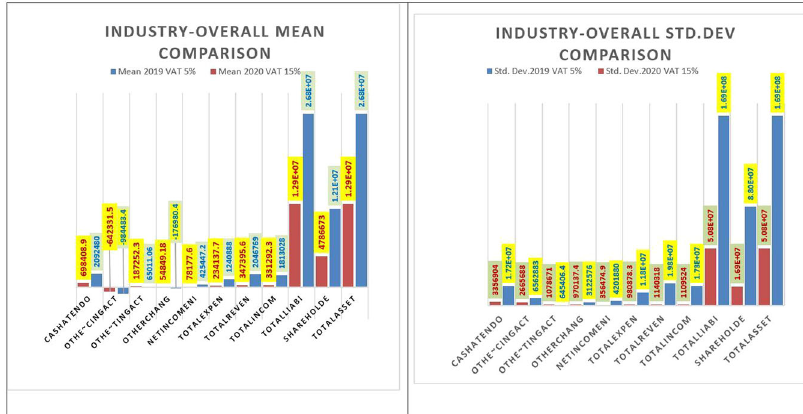
Fig. 8 Increase or decrease in values of fi nancial statements' key indicators in term of the average between